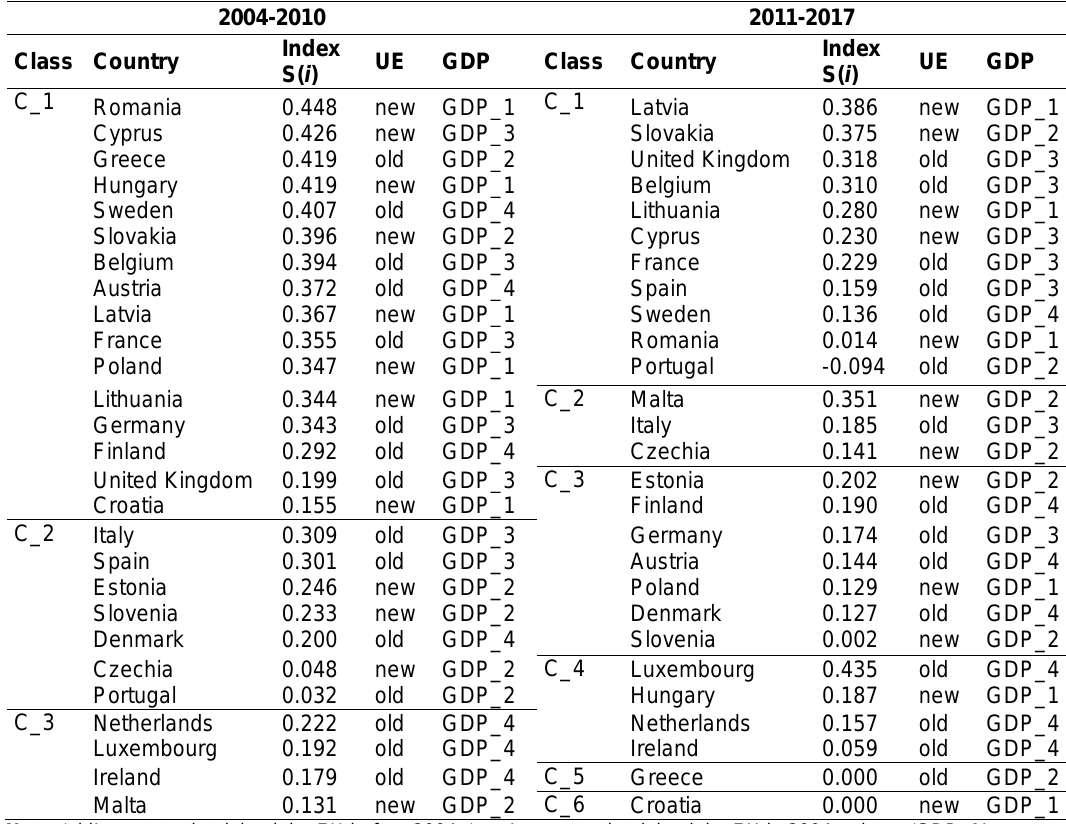
Table 2. Compositions of the clusters obtained as a result of the partitioning of the European Union member states on the basis of data from 2004-2010 and